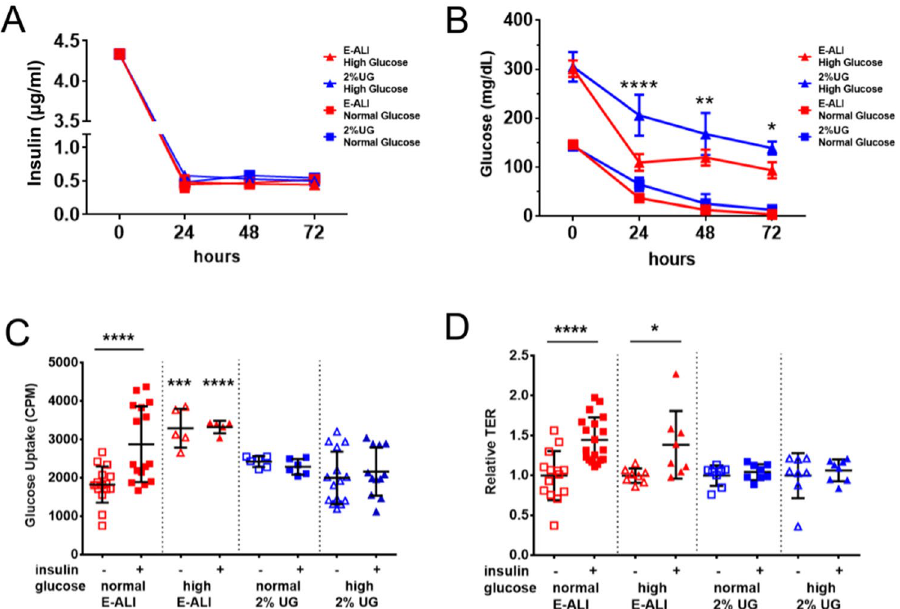
Figure 4. Glucose and insulin sensitivity depends on differentiation medium. ( A ) Insulin consumption was comparable in all media tested. n = 4 samples, one biological replicate per condition. ( B ) Glucose consumption of differentiated, expanded P0 airway epithelial cells of mixed tracheal/bronchial origin. Red triangles and squares indicate cells cultured in E-ALI medium and blue triangles and squares indicate cells cultured in 2% Ultroser G (2% UG) medium. High glucose = 300 mg/dL glucose in the base media (triangles); Normal resting glucose = 150 mg/dL glucose in the base media (squares). Glucose consumption was significantly higher for cells in high glucose E-ALI as compared with cells in high glucose 2% UG (n = 4 samples, one biological replicate; **** P < 0.0001; ** P = 0.0085; * P = 0.014, by two way ANOVA). ( C ) Cells differentiated using E-ALI medium containing normal resting glucose elicited a significant increase in insulin stimulated [ 3 H]-2-D-glucose uptake. n = 3–6 samples from n = 1 (E-ALI high glucose, 2% UG normal glucose), 3 (2% UG High glucose) or 4 (E-ALI normal glucose) biological replicates; *** P = 0.0001; **** P < 0.0001, by one-way ANOVA. ( D ) Cells cultured in E-ALI showed significant increases in relative transepithelial resistance (TER) in response to insulin regardless of glucose content, cells cultured in 2% UG did not. n = 4—11 samples from n = 3 (E-ALI normal glucose) or 2 (all others) biological replicates; * P = 0.015, **** P < 0.0001 by one-way ANOVA. All data is plotted as mean ±